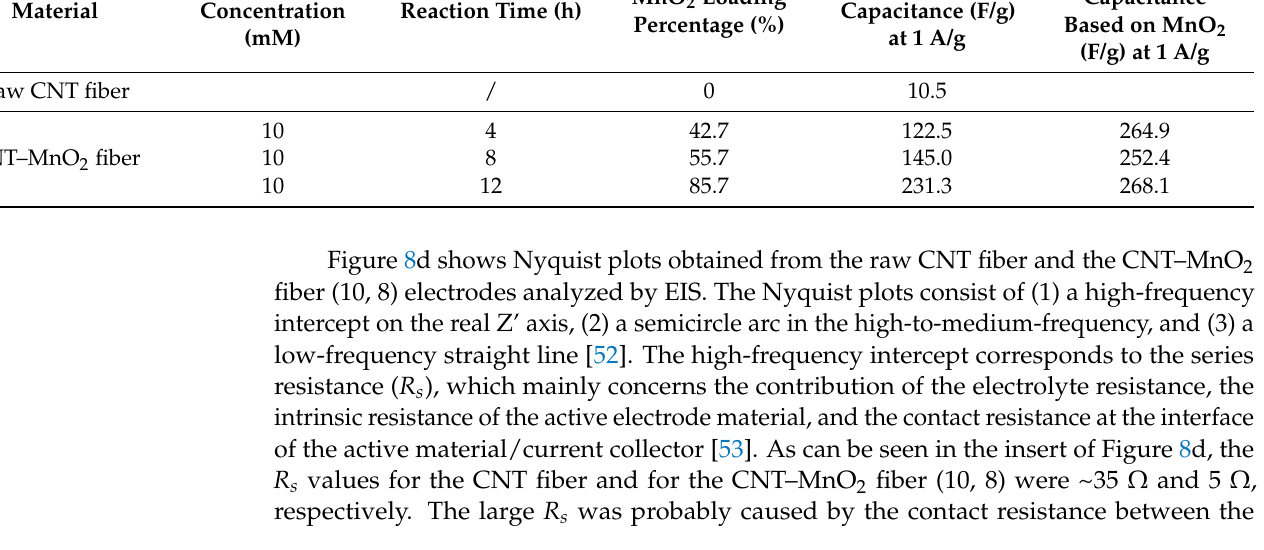
Table 5. Capacitance values for raw CNT fiber and CNT–MnO 2 fiber electrodes derived from CP detected in 1 M Na 2 SO 4 .